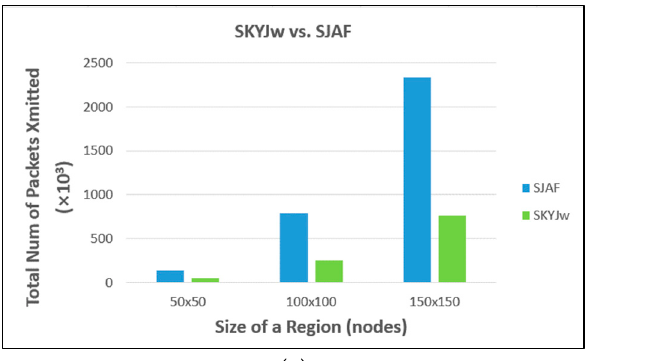
Figure 12. Comparison between SKYJw and SJAF or EXTERNAL.